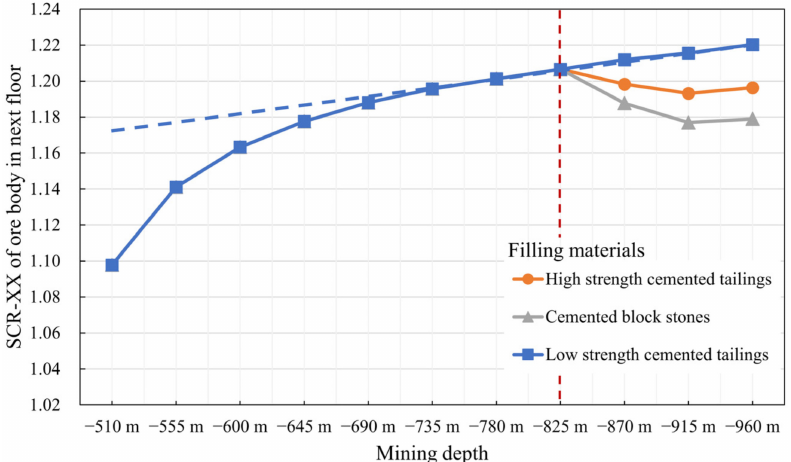
Figure 12. Variation of SCR with mining depth in the next layer of the excavated